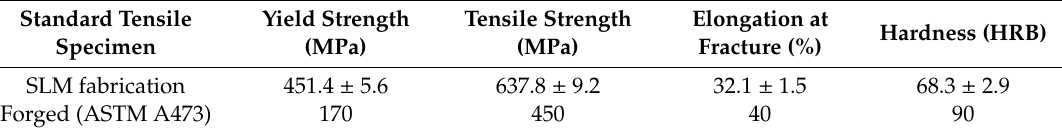
Table 4. Mechanical properties test results